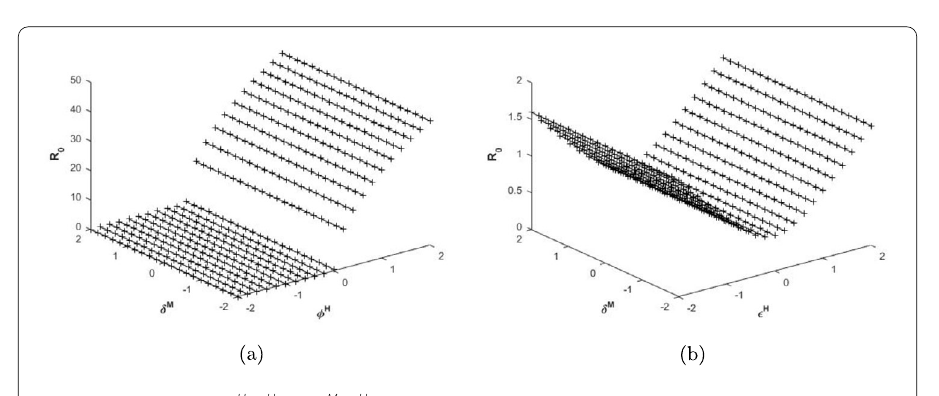
Figure 10 Influence of φ H , (cid:6) H and δ M , (cid:6) H on R 0